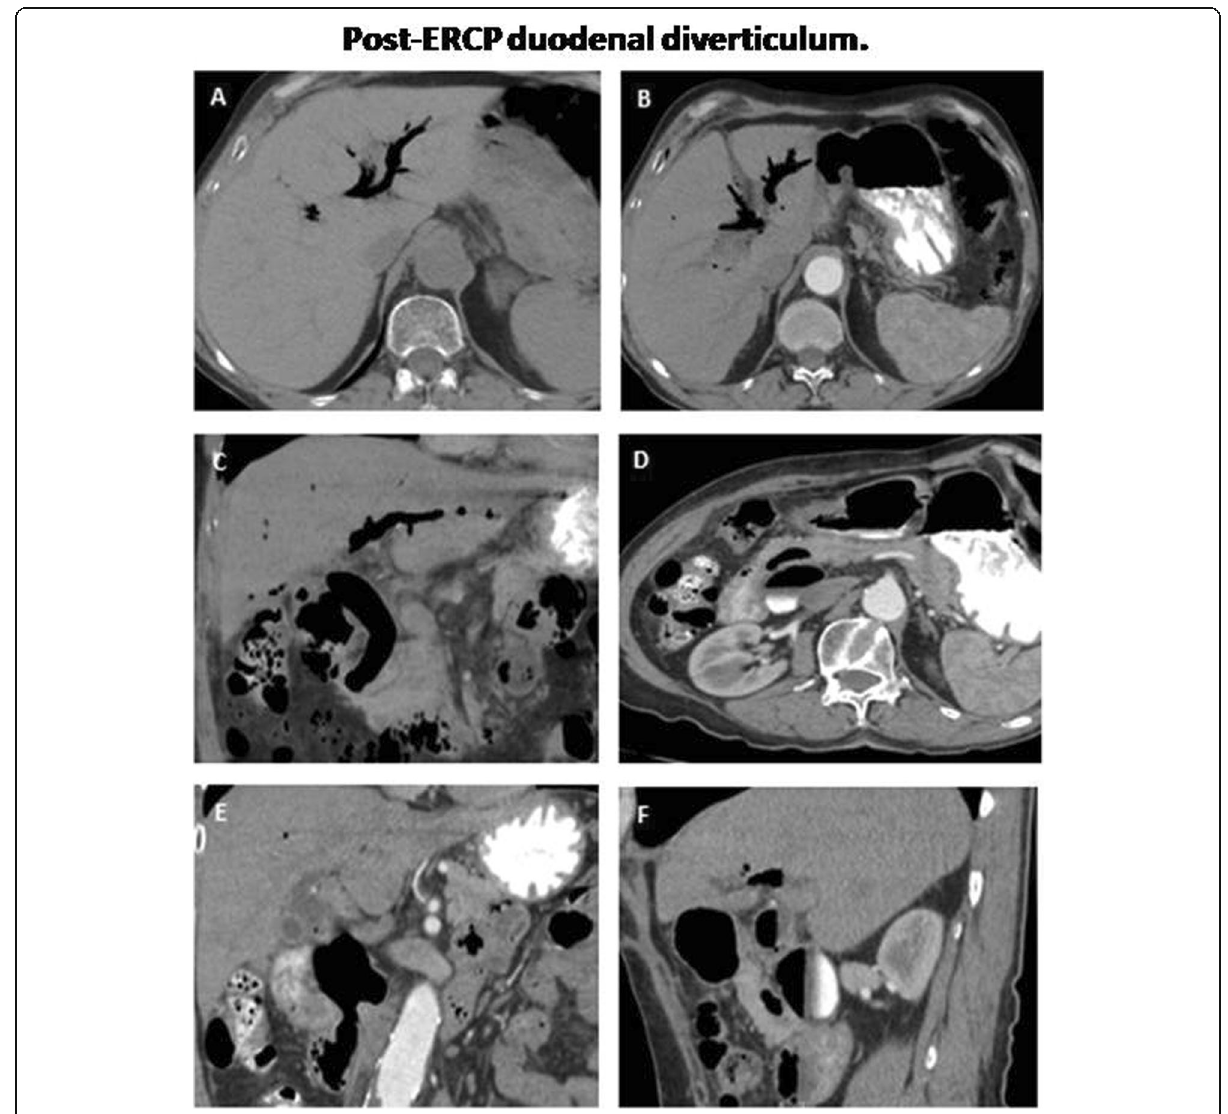
Fig. 3 Post-ERCP duodenal diverticulum. Benign obstructive jaundice with moderate IHBRD and pneumobilia caused by a duodenal diverticulum arising from the third part of the duodenum following iatrogenic ERCP trauma. "Male patient 58 years old presented by epigastric pain and progressive jaundice. (History of ERCP two months ago). a , b Axial pre-contrast and portal phase images showing mild to moderate pneumobilia more prominent at the LT hepatic lobe. c Coronal portal phase image showing dilated CBD with free air inside. d Axial oblique reformatted post- contrast (portal venous phase) image showing dilated CBD with air inside and posterior to it a cystic lesion with air fluid level within. e Coronal oblique reformatted post-contrast (portal venous phase) MDCT cholangiography image showing cystic lesion assuming a medial location to the second part of the duodenum and superior location to the 3rd part of the duodenum which is being continuous inferiorly via a wide isthmus. f Sagittal oblique reformatted MDCT cholangiography image showing the relation of the cystic lesion to the CBD (posterior to it) and the third part of the duodenum (superior to